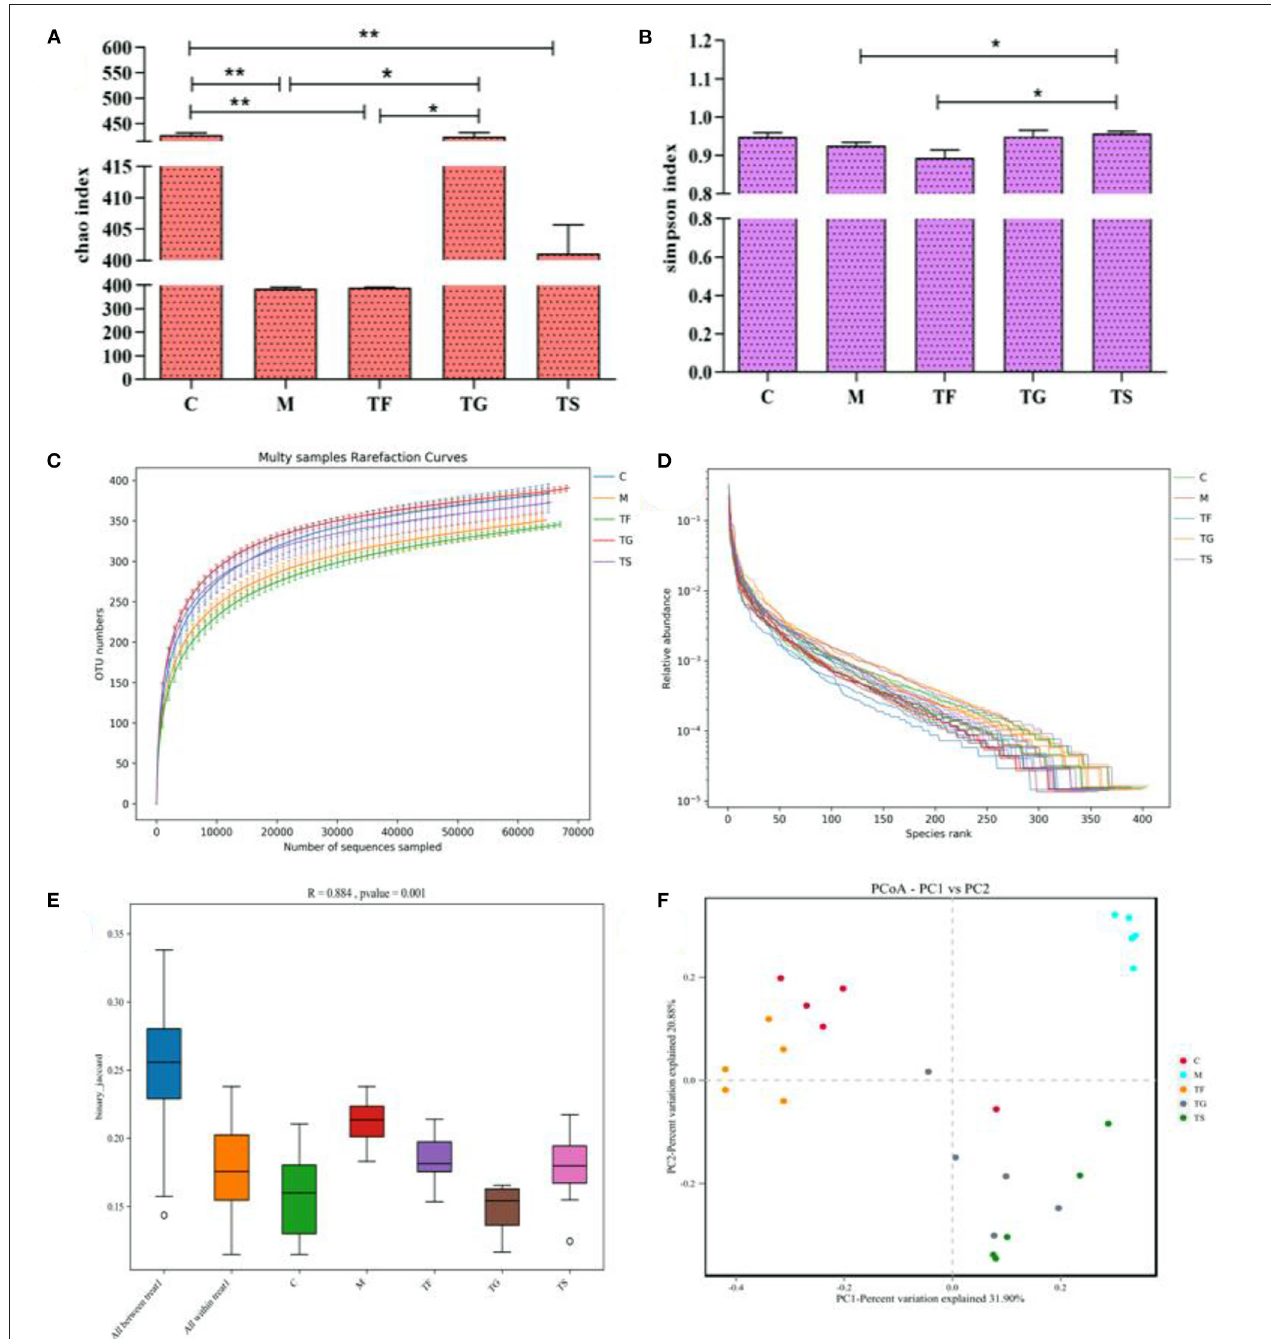
FIGURE 5 | Effects of different treatments on gut microbial diversity in mice. (A) Chao index; (B) Simpson index; (C) Rarefaction curves of OTUs; (D) Rank abundance curves; (E) Boxplot of β -diversity distances; and (F) Between-group principal component analysis (PCA) plots. Results are expressed as means and standard deviations of five samples for each group (25 total samples). The values with ** symbols indicate that they differ substantially ( p < 0.05) from each